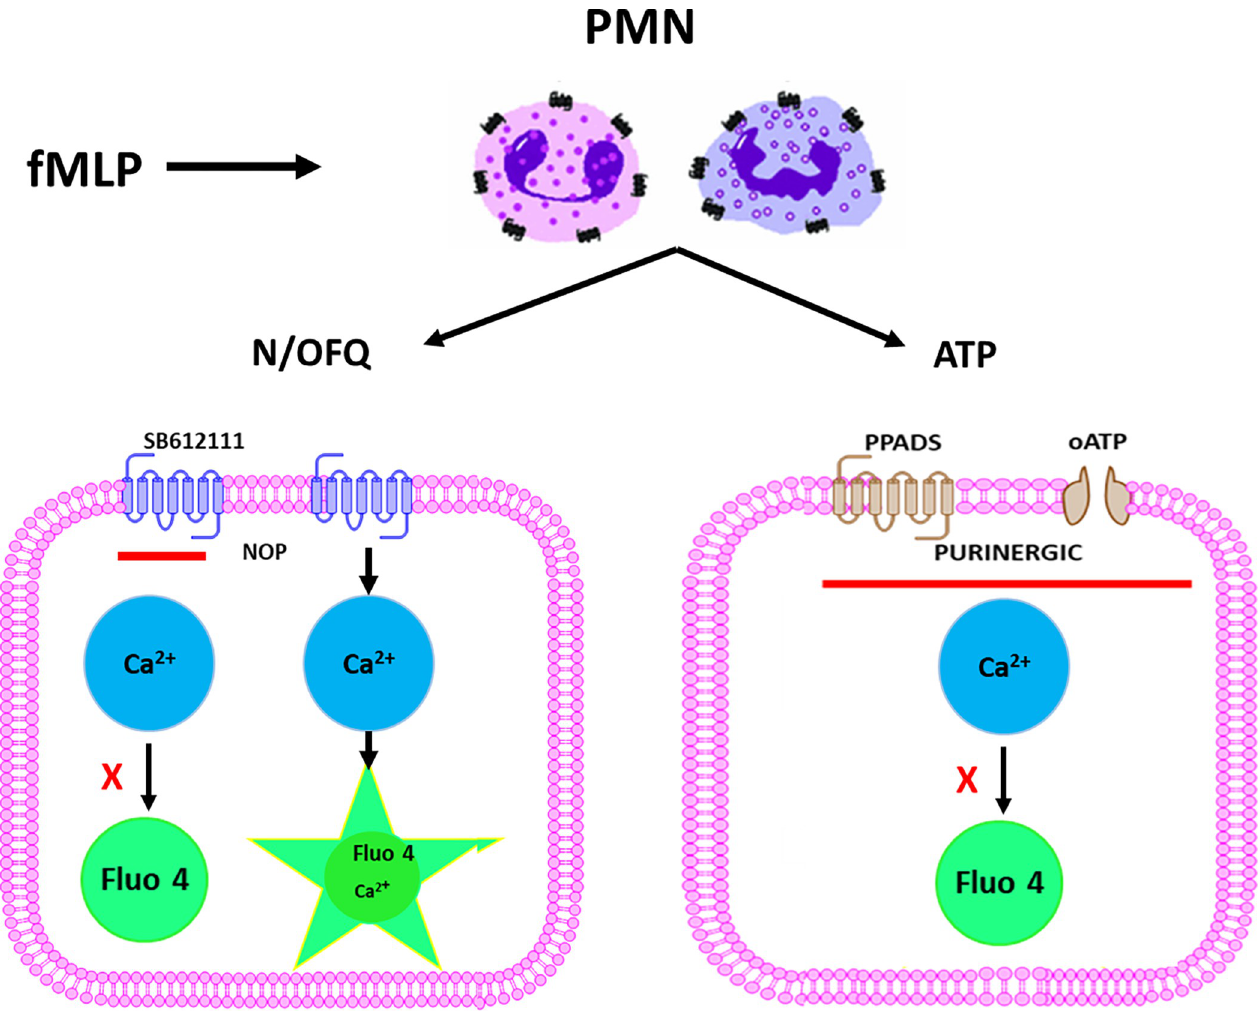
Fig 1. Schematic of representation of the immune cell bioassay. If immune cells produce N/OFQ peptide and release it in response to stimulation (with fMLP), released N/OFQ will bind to NOP receptors and chimeric G-protein on the surface of the CHO cell leading to an increase in calcium. This calcium increase can be measured using the fluorescent calcium indicator dye FLUO-4 and should be sensitive to NOP antagonists (SB-612111). CHO cells also express purinergic receptors that increase calcium in response to ATP also potentially released from PNMs; this can be blocked with purinergic antagonists (PPADS and